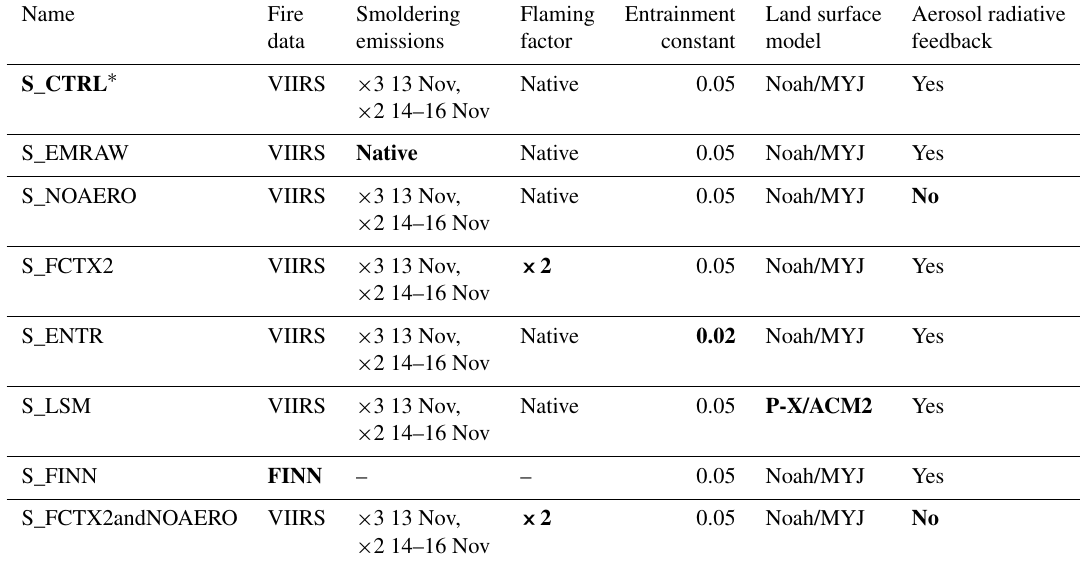
Table 1. Summary of sensitivity simulation setup.